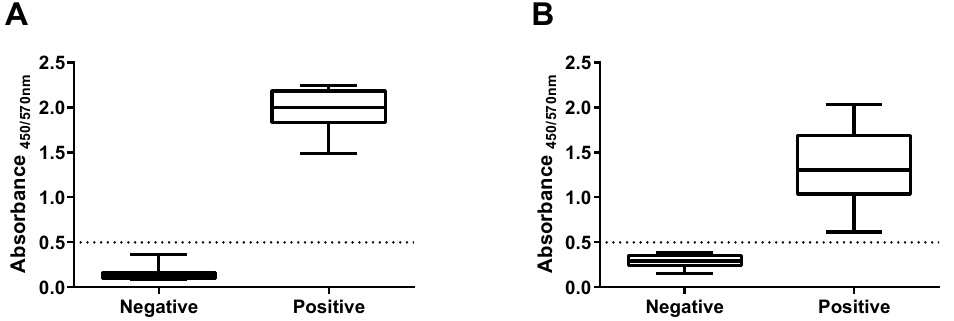
Figure 2. Absorbance values of the 15 negative and 15 positive COVID-19 samples were used to standardize the ( A ) S1- and ( B ) RBD-based IgG assays. Each absorbance value in the plots is the average of six measurements: two sets of triplicates, with one set of triplicates performed one day, and another set of triplicates performed on a different day.